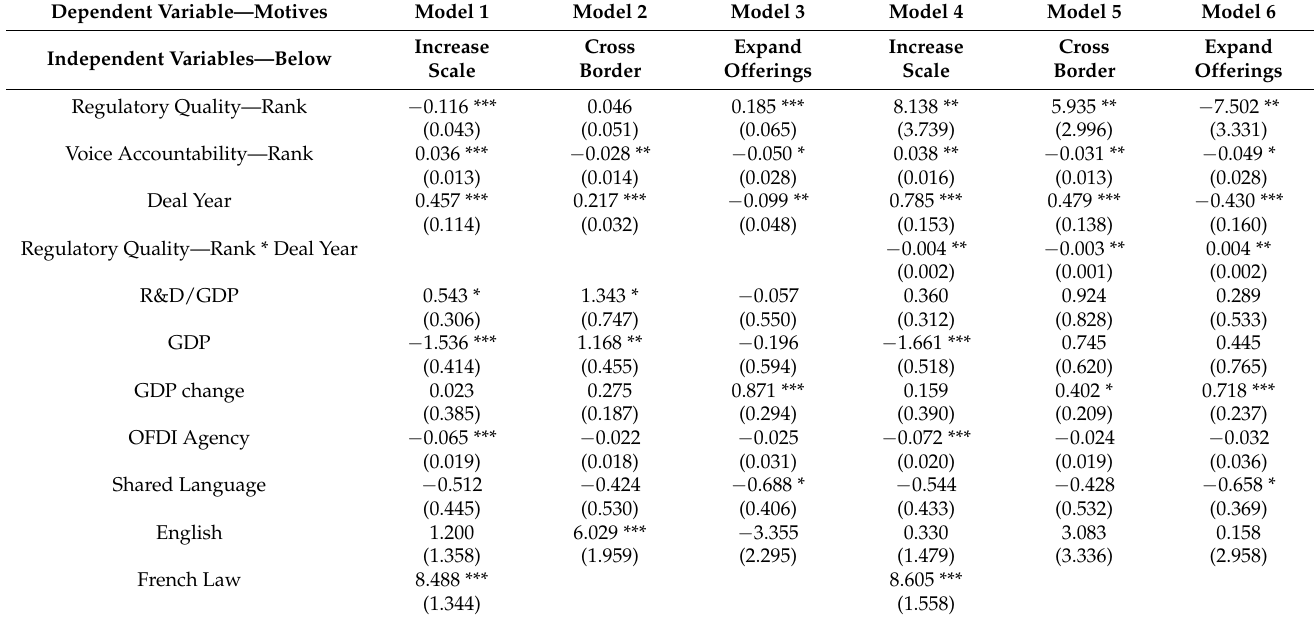
Table A5. Logistic regressions for the three main